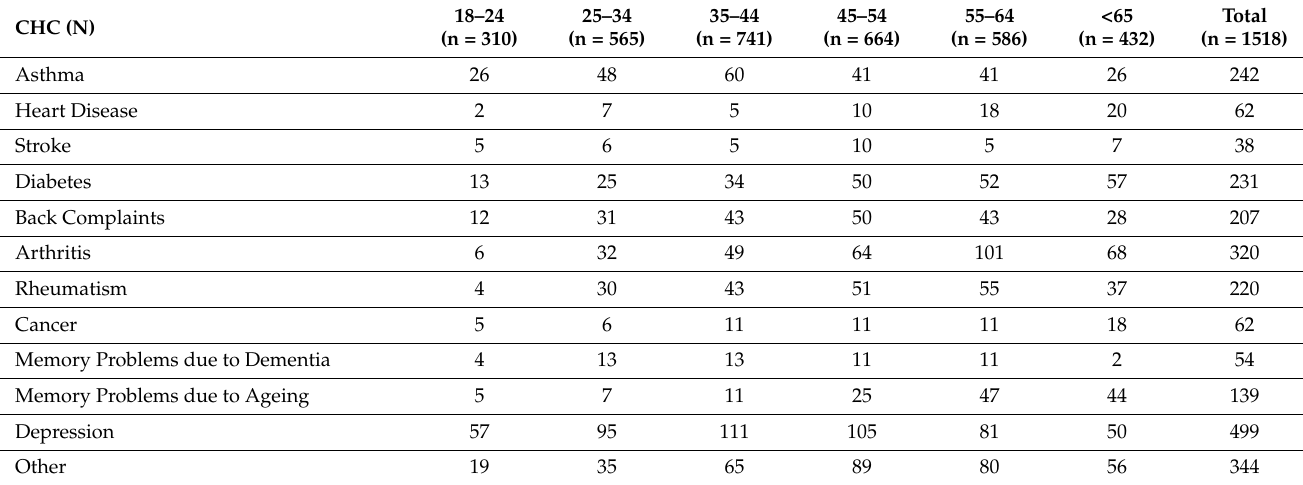
Table A1. Prevalence of CHC per age group.